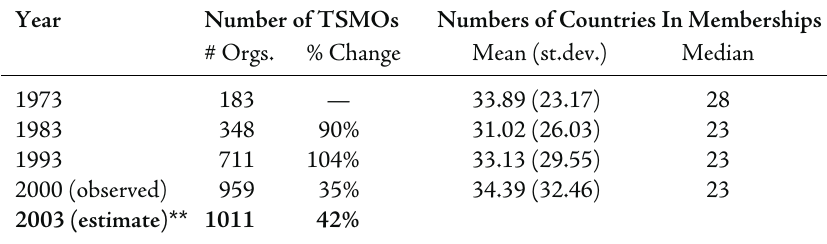
Table 1: Size and Geographic Dispersion of Transnational Social Movement